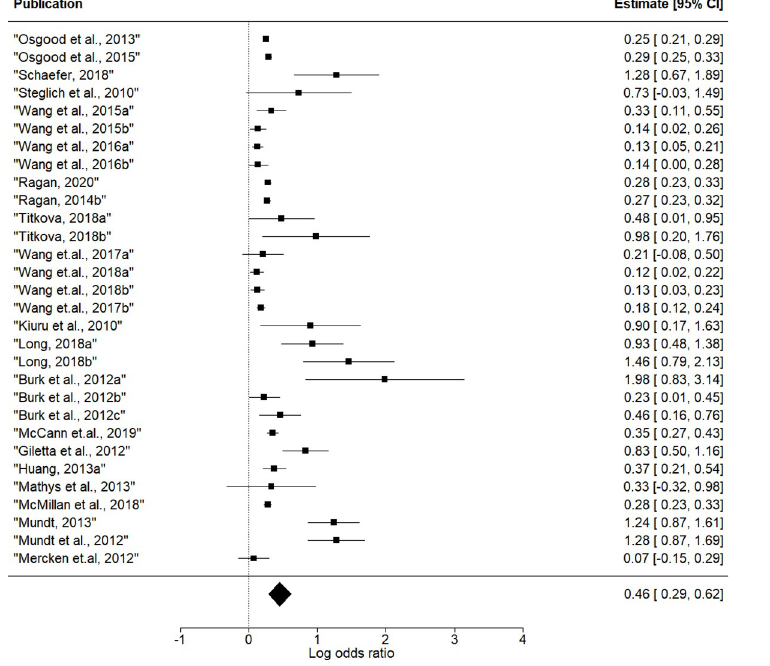
Fig 3. Forest plot of effect size estimates for peer selection.